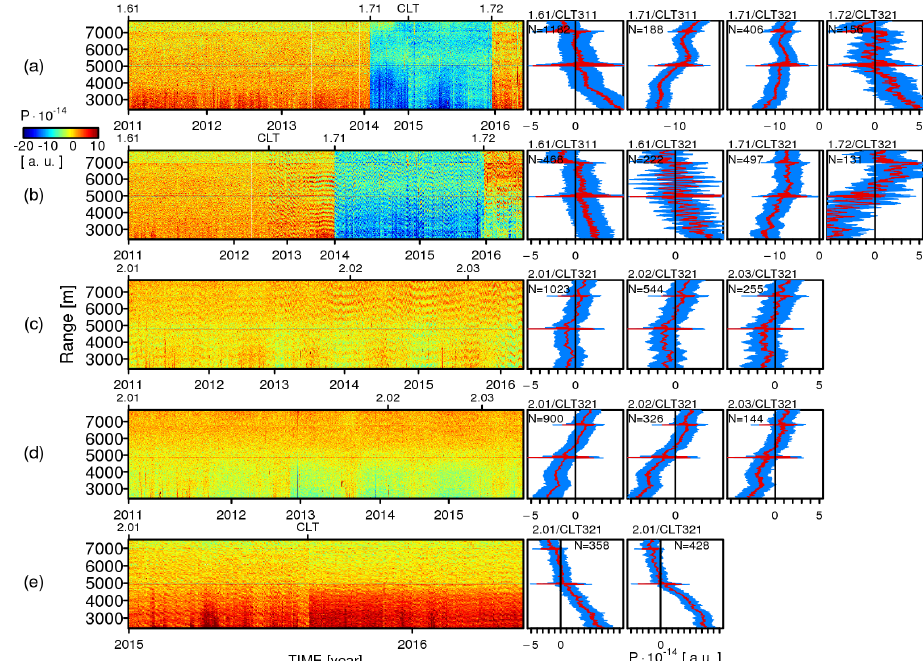
Figure 2. Signal P (derived from reported signal by reverting range correction) observed with Vaisala CL31 sensors operating with (a, b) en- gine board CLE311 + receiver CLR311 (A, B) and (c, d, e) CLE321 + CLR321 (C, D, S), respectively (Table 2); (a–d) January 2011– April 2016 and (e) May 2015–April 2016 for range >2400m. Observations (4h around midnight, 22:00–02:00 UTC) are hourly means of profiles when clouds detected for <10% of the hour, no fog, average window transmission >80%, laser pulse energy >98%, and data availability >90%. Left: top axis shows firmware updates (version 1.71, then 1.72 for sensors A and B; versions 2.02, then 2.03 for C and D; version 2.01 for S) and hardware changes/upgrades (transmitter CLT311 replaced by CLT321 for sensors A and B; CLT321 replaced by a new CLT321 for sensor S). Right: median profiles (with IQR shading) of all selected observations grouped by firmware version and transmitter, with N indicating the number of